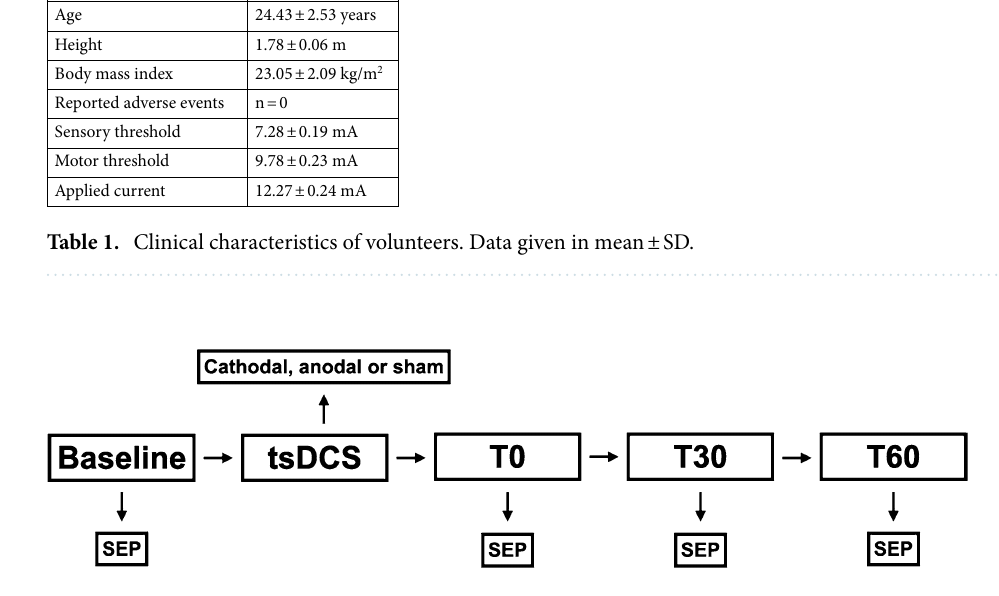
Figure 1. Study design: each study participant underwent three individual sessions of the procedure shown above with a latency of at least 1 week between these sessions. During each session 15 min of either cathodal, anodal or sham transcutaneous spinal direct current stimulation (tsDCS) was applied to the participant. Before tsDCS, a baseline tibial nerve SEP was recorded (Baseline). tsDCS was then applied in randomized individual order. The stimulation was followed by three SEP recordings with the first one being started directly after tsDCS (T0). Another two SEP recordings were performed 30 (T30) and 60 (T60) min after